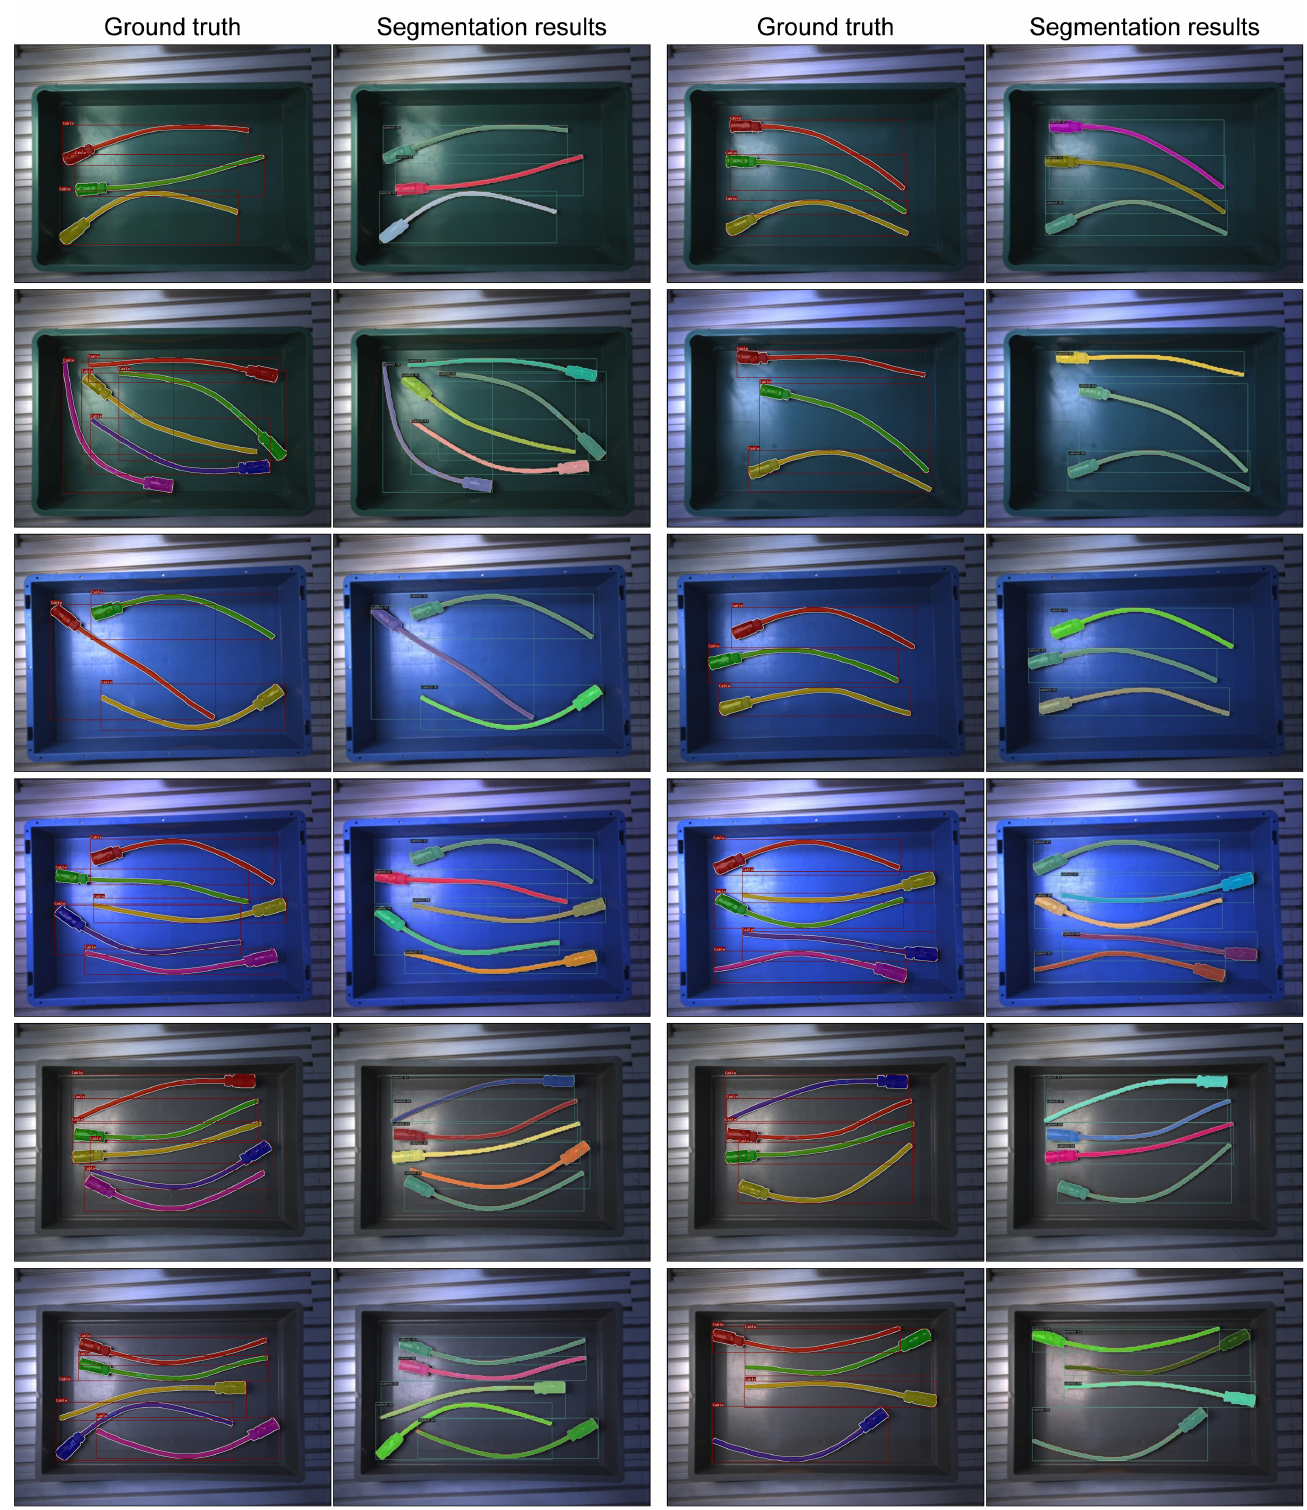
Figure A2. Ground truth masks and instance segmentation results for high-voltage cables in the scenario